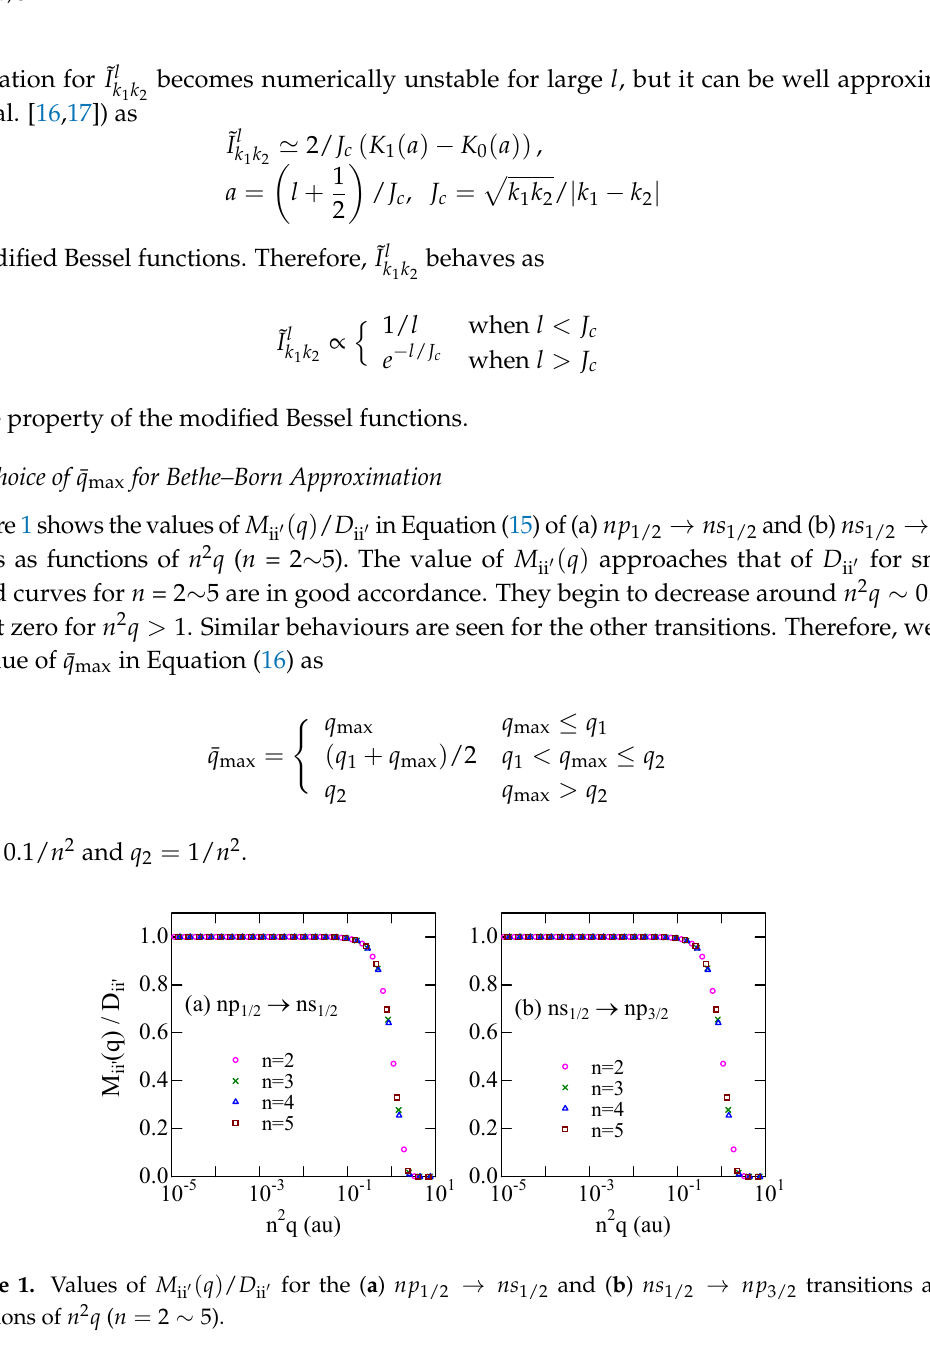
Figure 1. Values of M functions of n 2 q ( n = 2 ∼